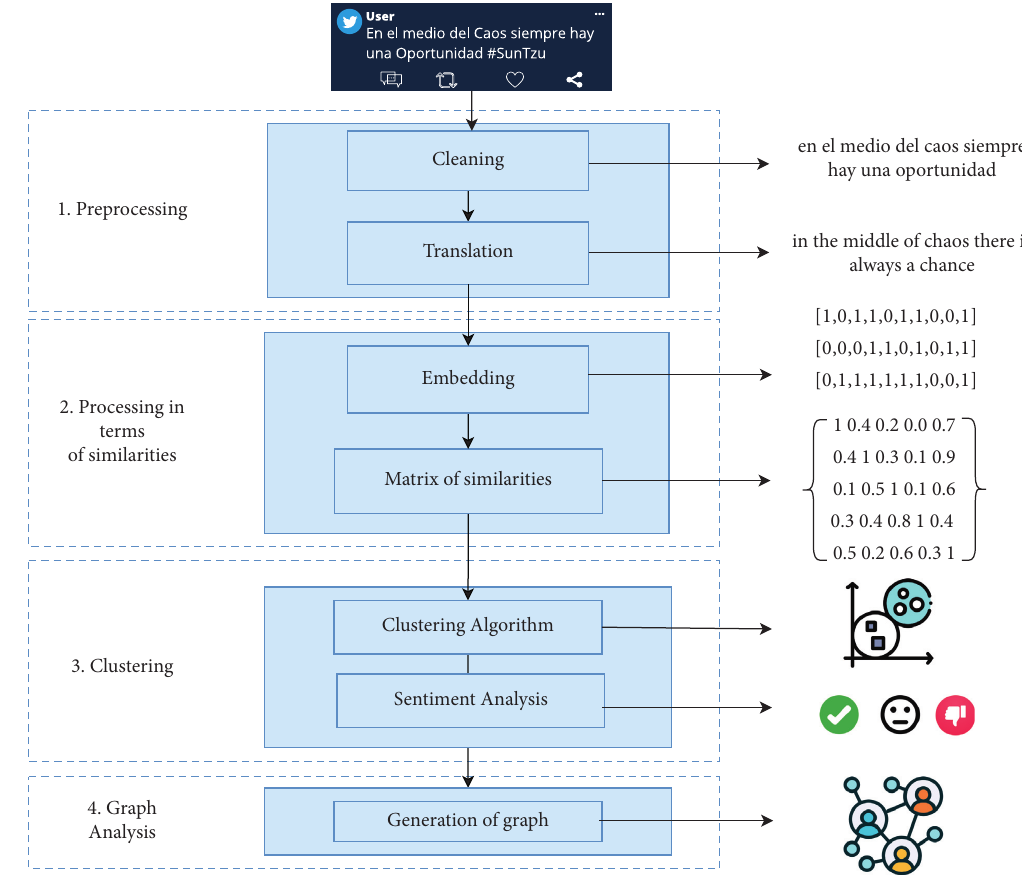
Figure 1: Methodology of the proposed